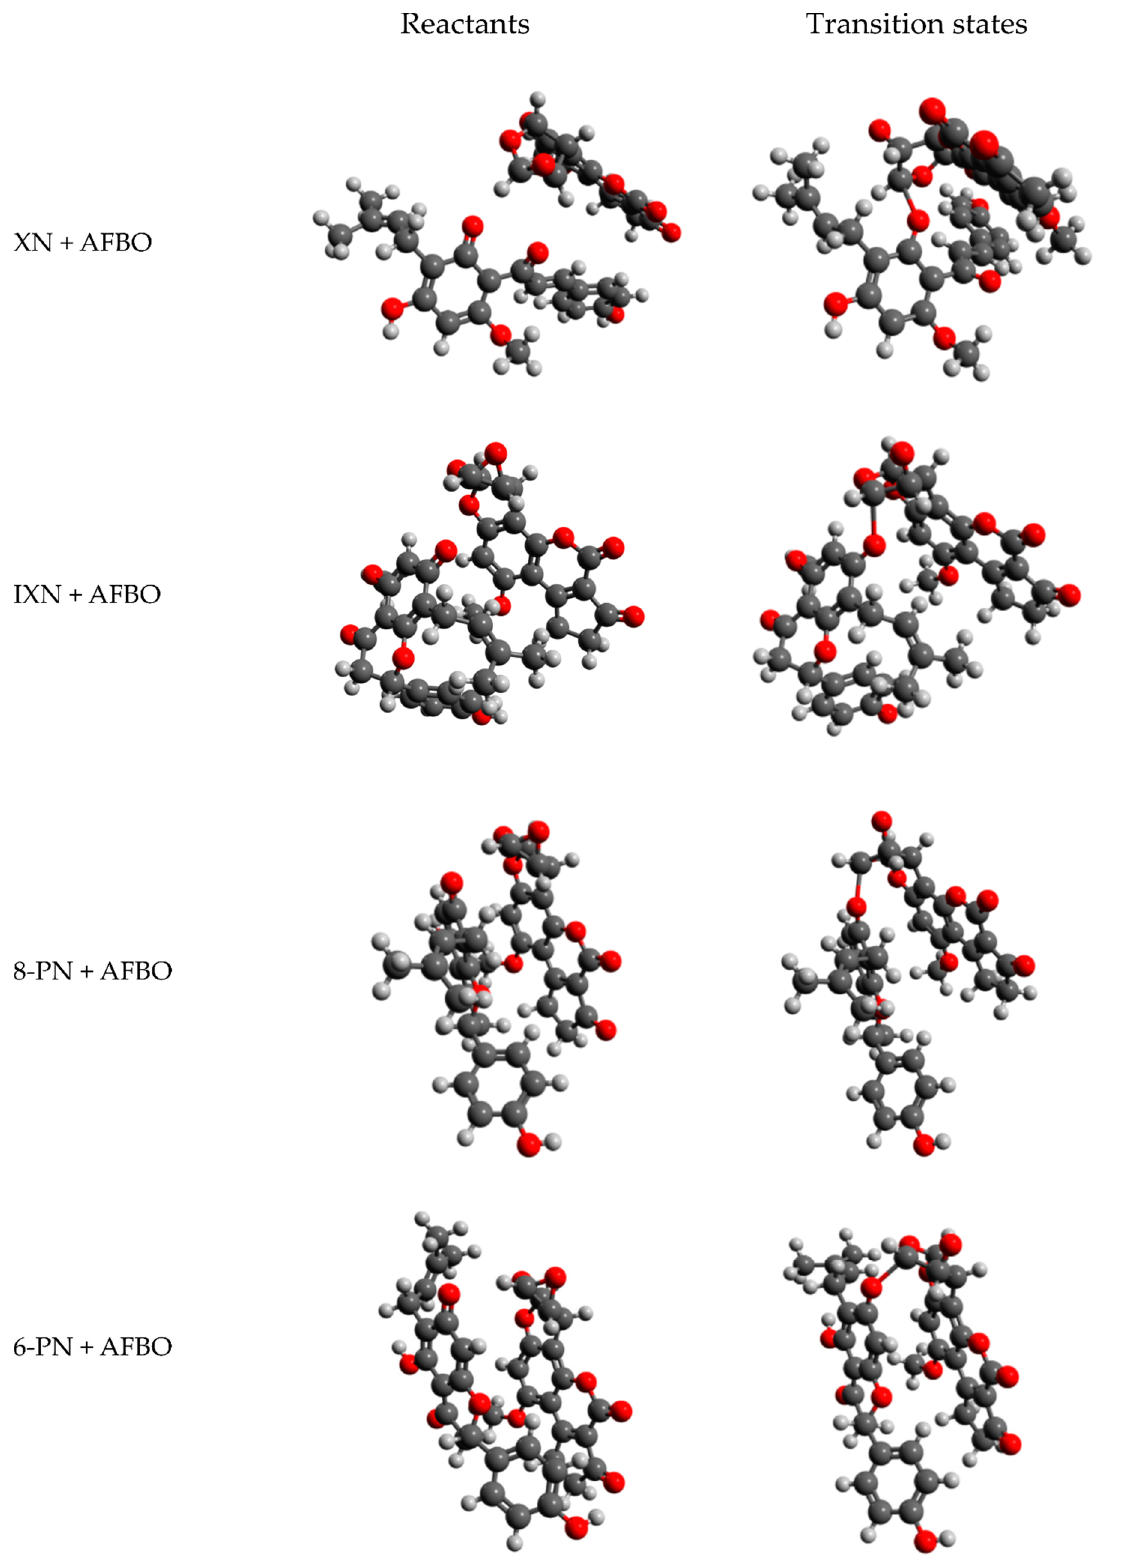
Figure 3. Visual representations of the reactant ( left ) and transition state structures ( right ) of the AFBO-XN, AFBO-IXN, AFBO-8-PN, and AFBO-6-PN complexes, obtained at the Hartree–Fock level of theory in conjunction with 6-311++G(d,p) basis set. The visual representations of reactant and transition states of the individual complexes clearly show the changes in orientation between the reactant and transition state structures as well as the change in molecular orientation after bonding.